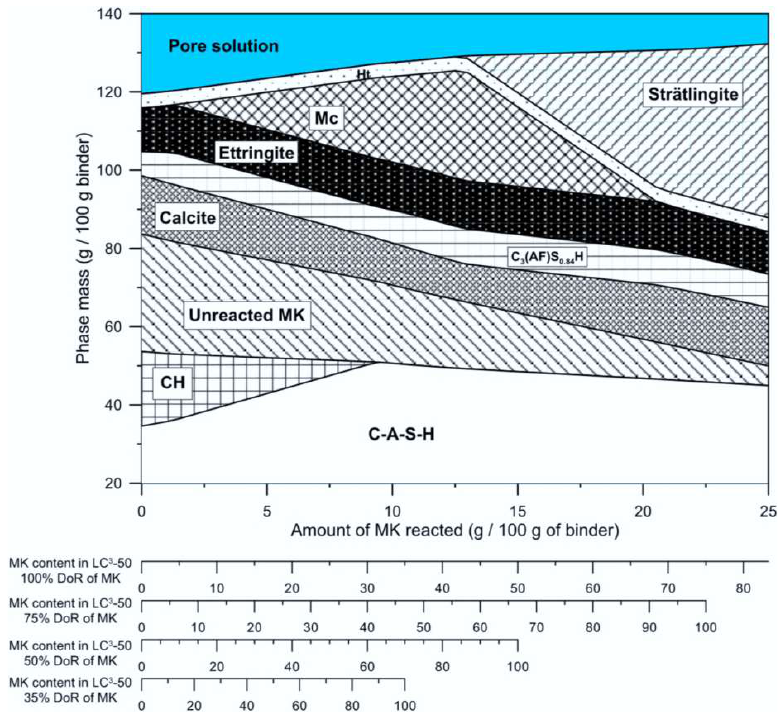
Figure 9. Thermodynamic model for phases of an LC 3 -50 system in the presence of different amounts of MK [74].